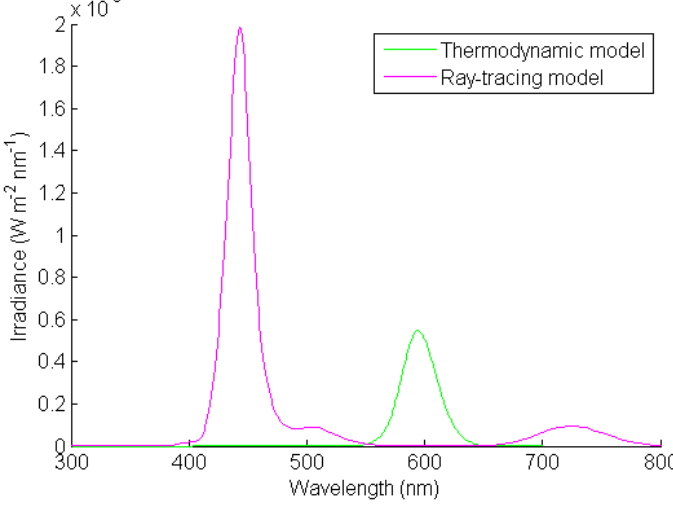
Figure 20. Separate contribution from the two models for with-mirror